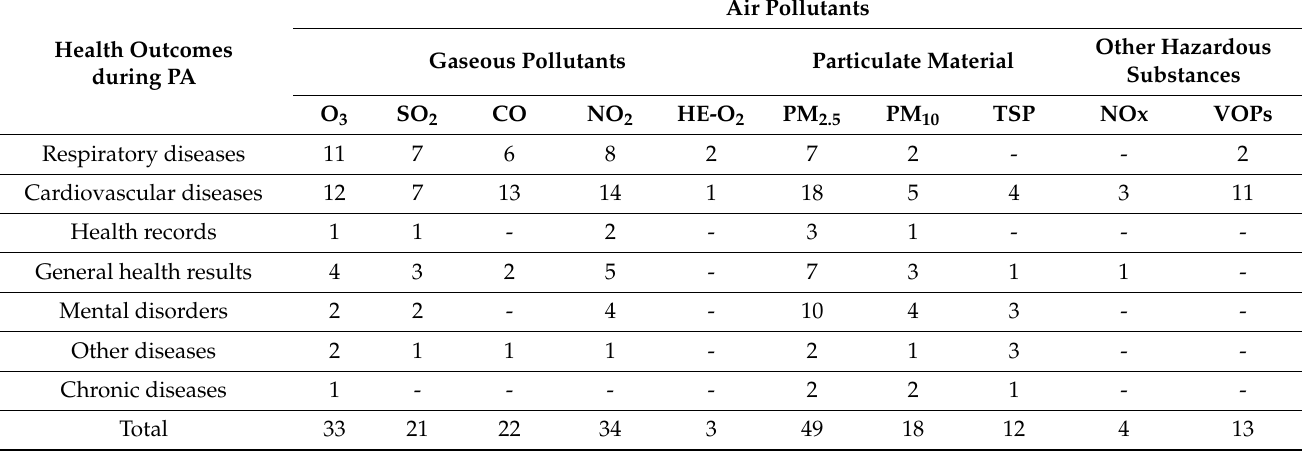
Table 3. Number of studies according to air pollutants and health outcomes of older adults during physical